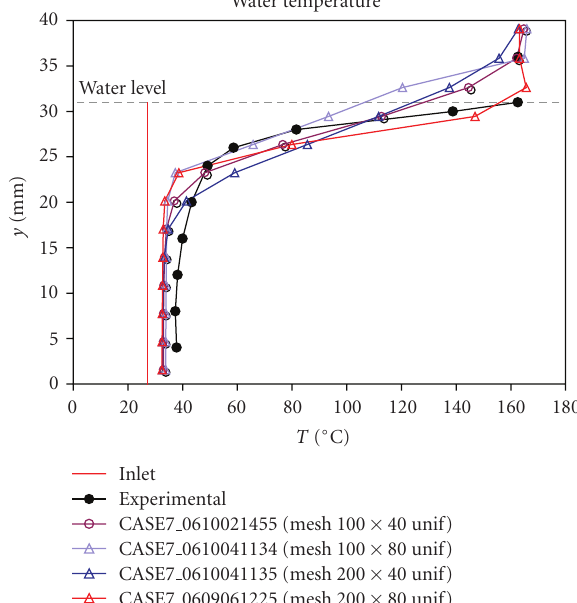
Figure 9: Water temperature profiles for HD2 model (discreet approach) mesh sensitivity